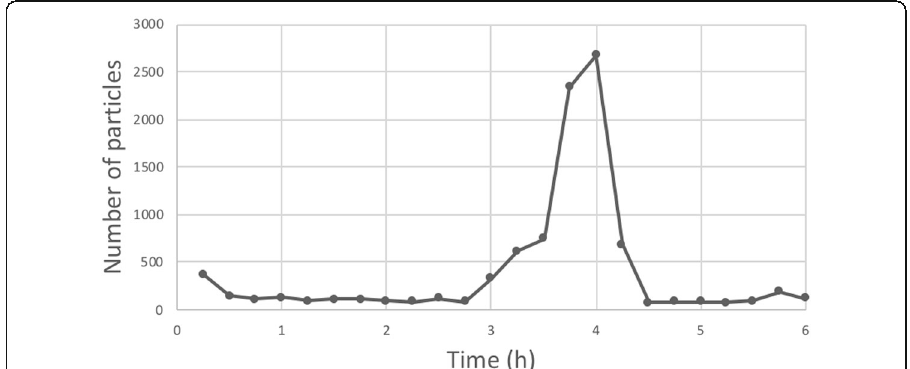
Fig. 2 Trend in particulate contamination over